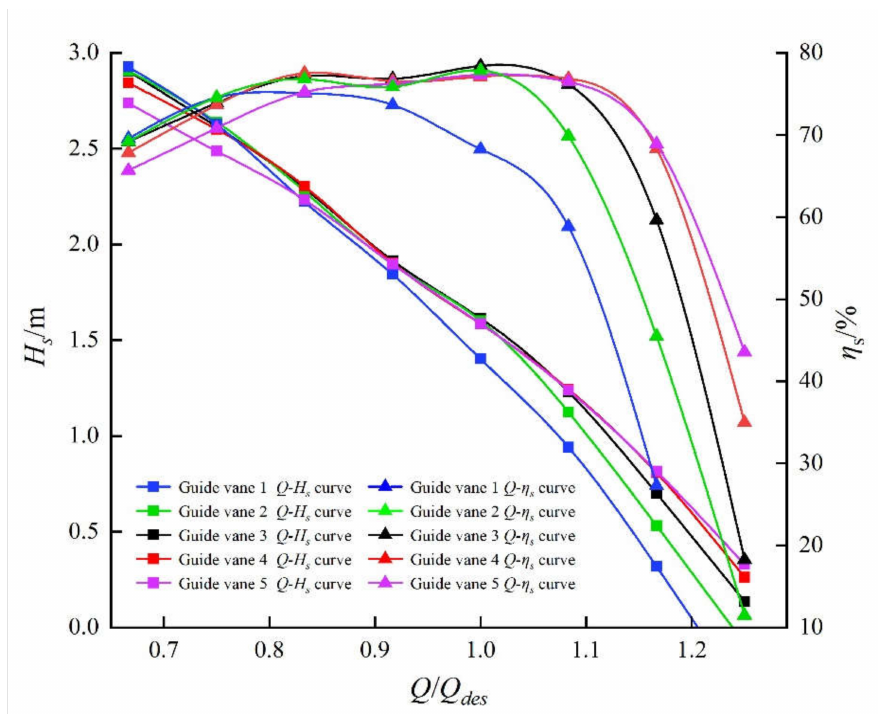
Figure 9. Calculation results of the hydraulic performance of S-type front shaft extension tubular pump device (different guide vane